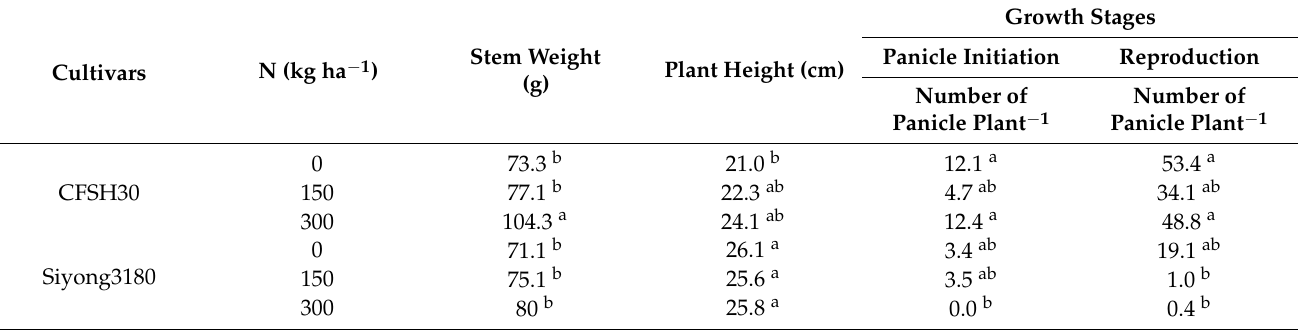
Table 4. Effects of N rates on stem weight, plant height, and number of panicles plant − 1 of two sorghum varieties during